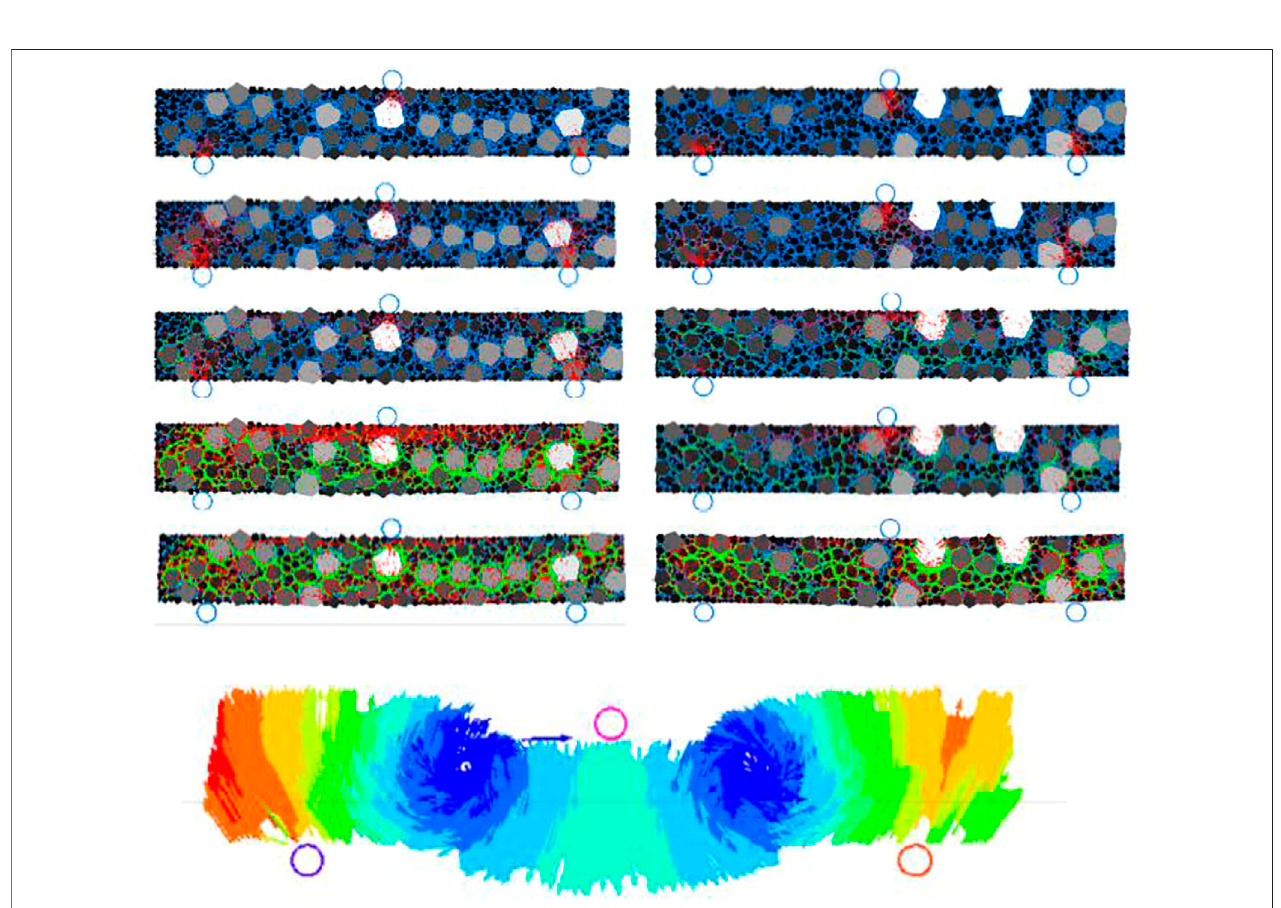
FIGURE 10 | Splitting test (indirect tensile test) and three-point bending test samples of the asphalt mixtures with the DEM models (Nian et al., 2021).